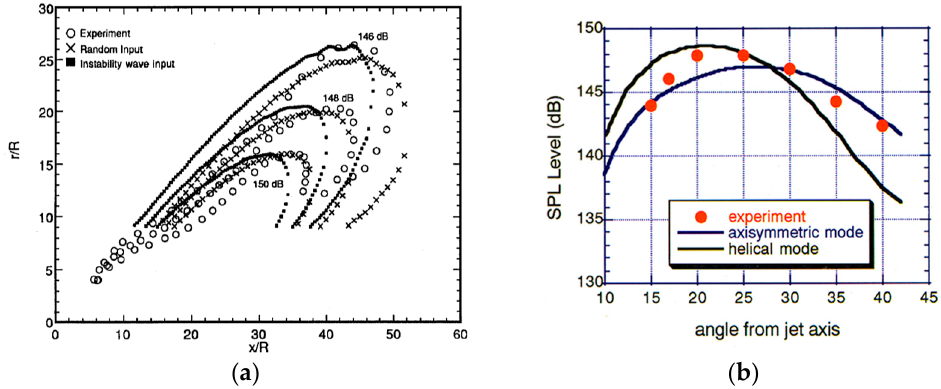
Figure 16. Prediction of LEE for a supersonic jet M = 21 in comparison with the experiment. ( a ) Predicted sound pressure level in which the initial disturbances were axisymmetric but was taken either to be at St = 0.2 or computer-generated random disturbances (Ref. [58,61]). ( b ) Directivity at R/d = 24. The initial input disturbance to jet was taken to be either an axisymmetric or the first helical mode (Ref. [58,59]).